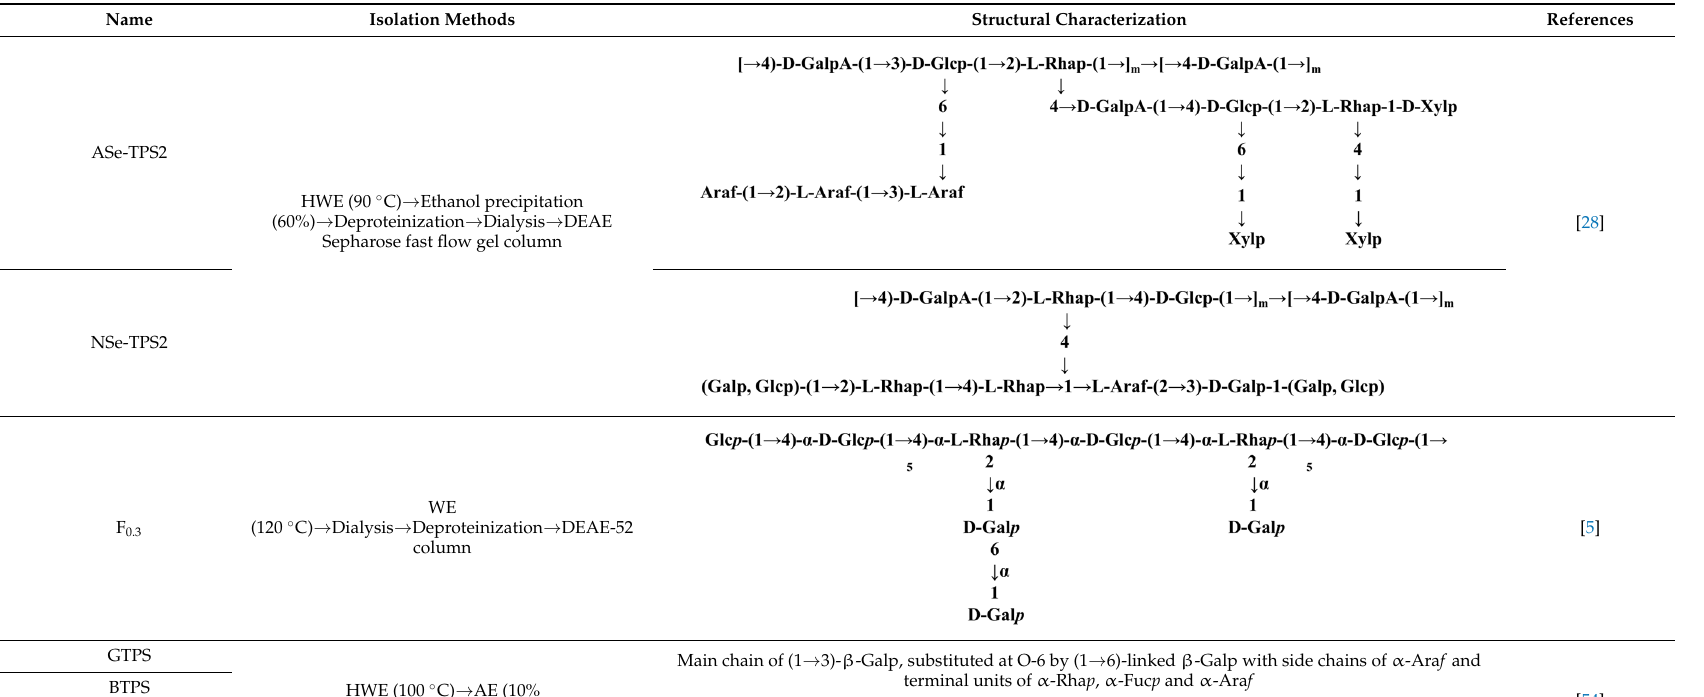
Table 2. Influencing factors on chemical structures of tea polysaccharides.